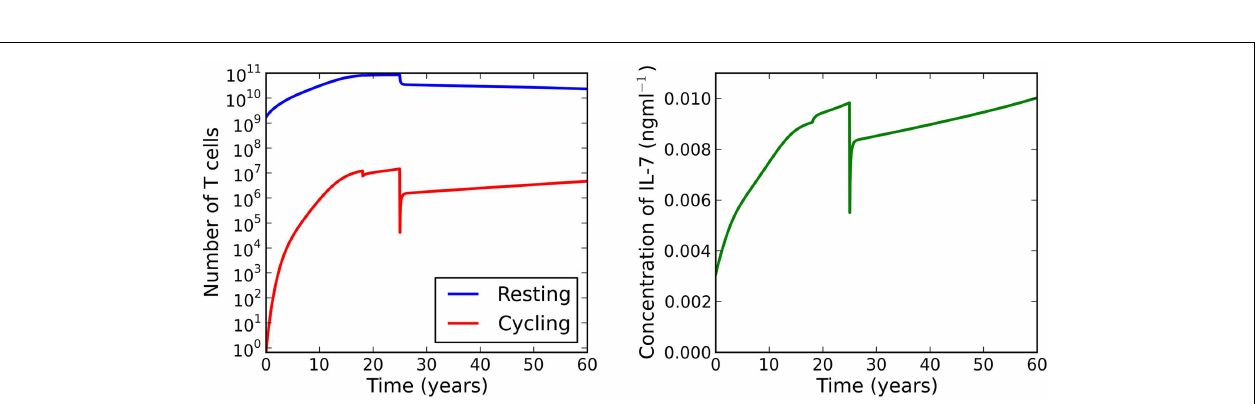
FIGURE 7 |Theoretical scenario in which we set µ C = 3 at 18years of age . At roughly 33years of age the model bifurcates resulting in a dramatic loss of naiveT cells.